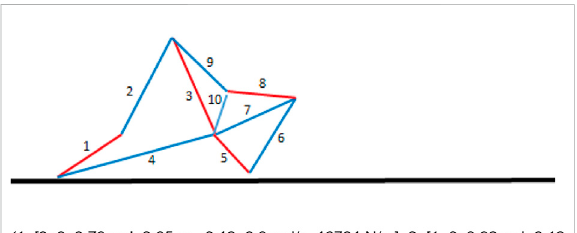
FIGURE 1 Exampleofarobotconstitutedby10springs.Thebottomand top part of the fi gure shows the genotype and the phenotype of the robot. The genotype is composed of a list of tuples. Each tuple includes 7 parameters that encode the index of the starting and the ending point of spring, the angle of the spring relative to the previous element, the length, the actuation, the oscillation phase and the stiffness of the spring (see also text). The top part of the Figure shows the corresponding phenotypic robot. The black line indicates the plane. The blue and red lines indicate the spring. The two colors indicate the springs which are currently expanding and contracting, respectively. The numbers indicate the ID of the corresponding genetic